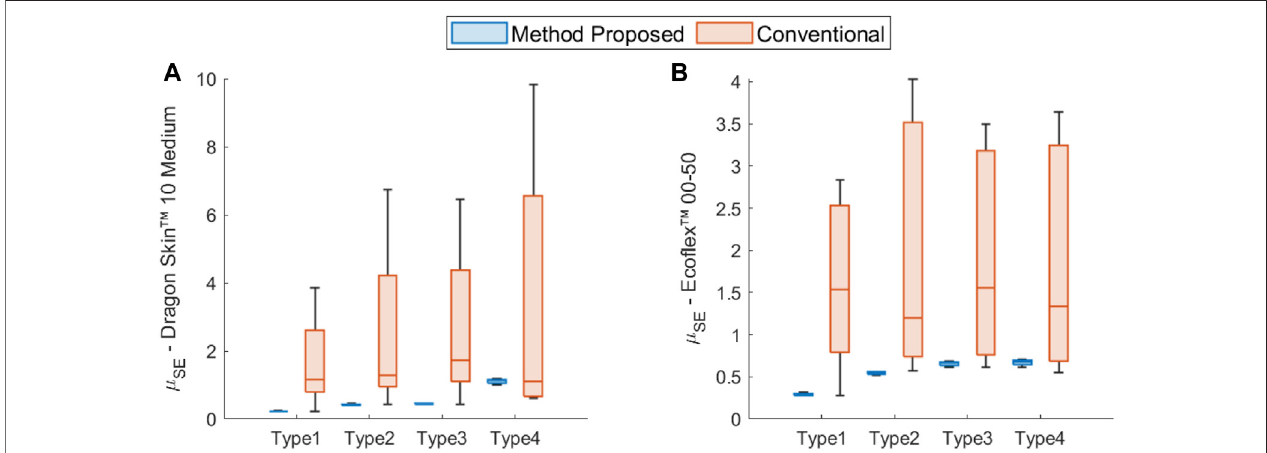
FIGURE 7 | Comparison of the statistical distribution of the standard error mean (see Eq. 10 ) between the models obtained through the proposed EIMI and the conventional fi tting approaches across the different geometry types for (A) Dragon Skin ™ 10 Medium and (B) Eco fl ex ™